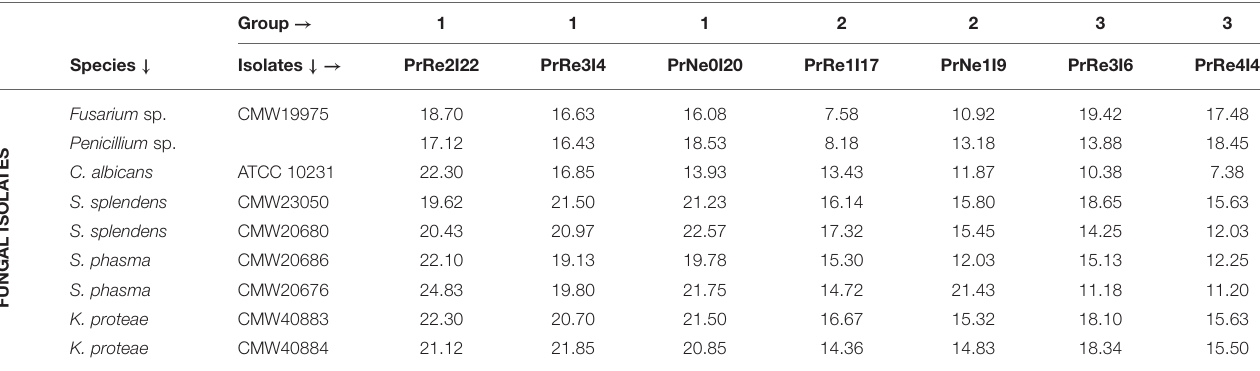
TABLE 2 | Zone of inhibition recorded in bioassay pairings. Group →